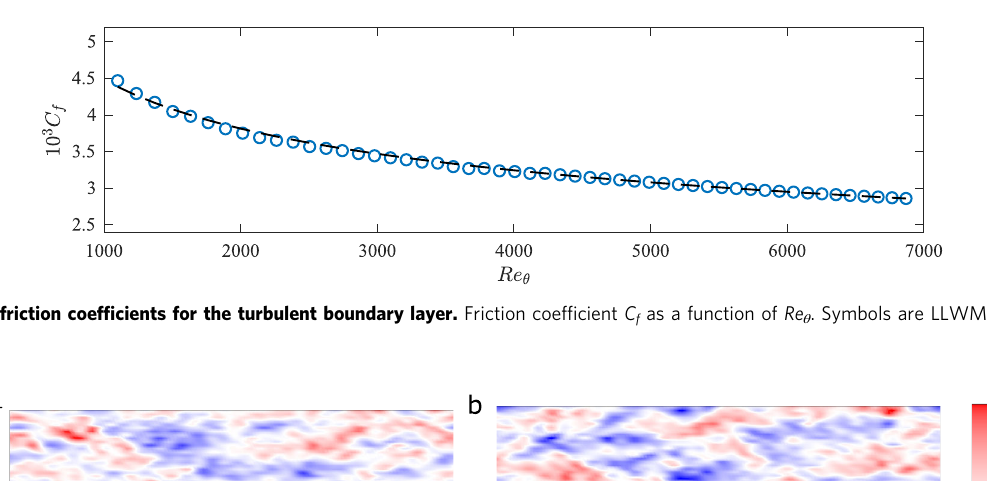
Fig. 4 Predicted mean velocity pro fi les for turbulent channel fl ow. Mean velocity pro fi les for the ( a ) VWM cases and ( b ) LLWM cases are shown in Fig. 3. Dashed line is u þ ¼ 1 = κ log ð y þ Þ þ B for κ = 0.41 and B = 5.2. The two largest Reynolds number cases for VWM are omitted as the velocity pro fi les are outside the plotted range.